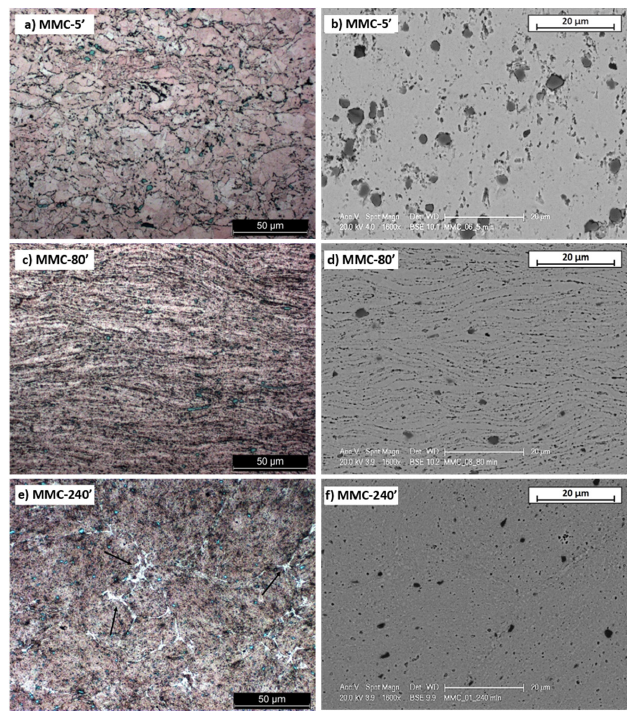
Figure 6. Optical and SEM micrographs of ( a , b ) MMC ‐ 5 ′ , ( c , d ) MMC ‐ 80 ′ , and ( e , f ) MMC ‐ 240 ′ .